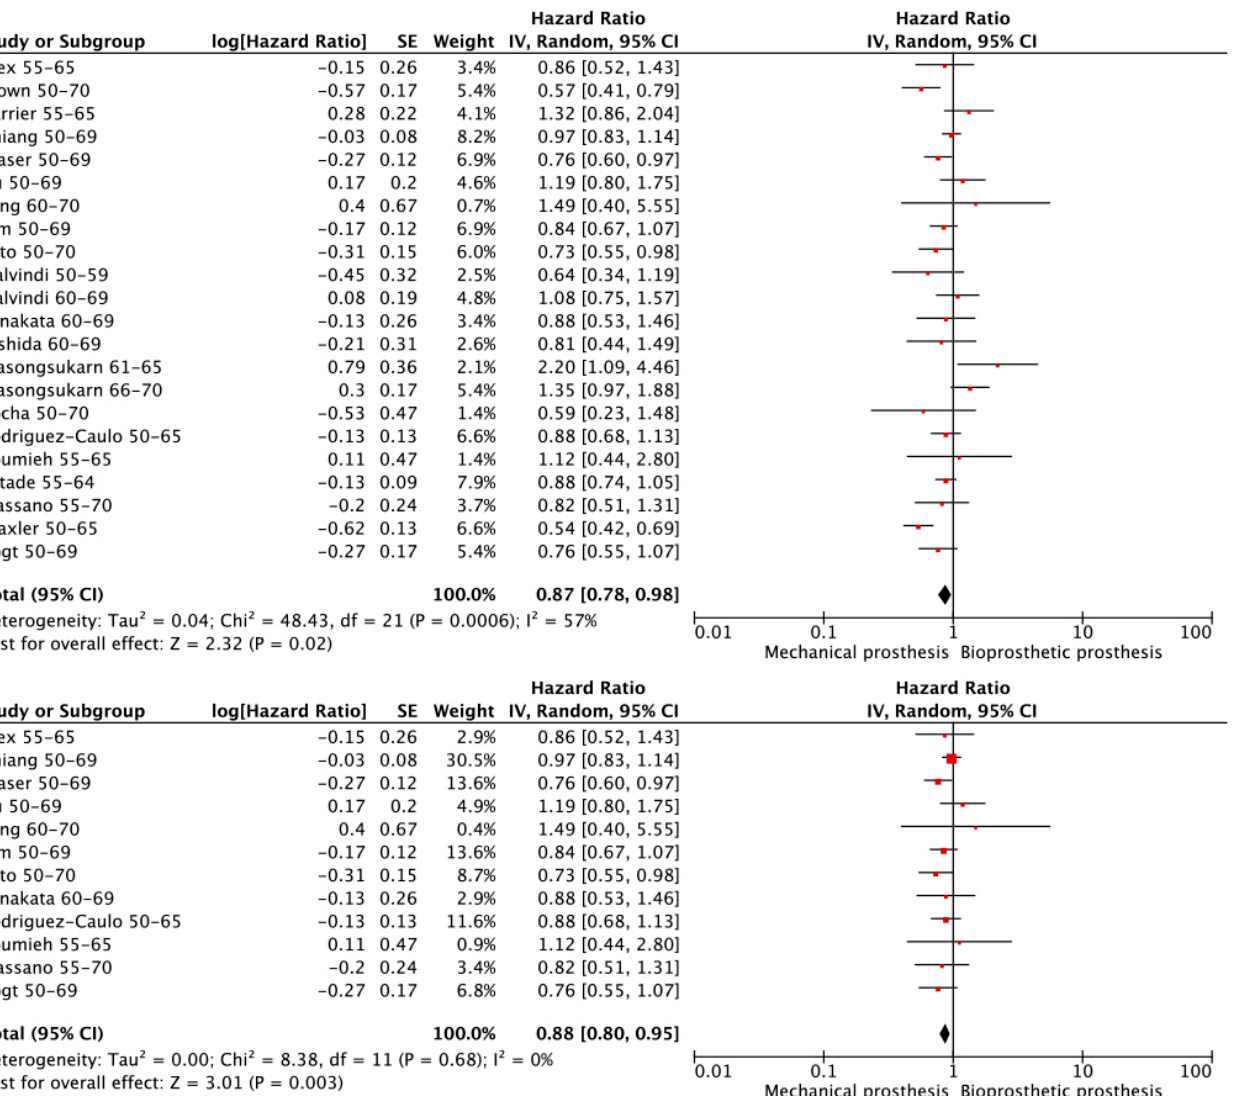
Figure 3. Meta ‐ analysis for long ‐ term survival. ( A ) Bioprosthetic vs. mechanical. ( B ) Bioprosthetic Figure 3. Meta-analysis for long-term survival. ( A ) Bioprosthetic vs. mechanical. ( B ) Bioprosthetic vs. mechanical (RCT or PSM). vs. mechanical (RCT or PSM).